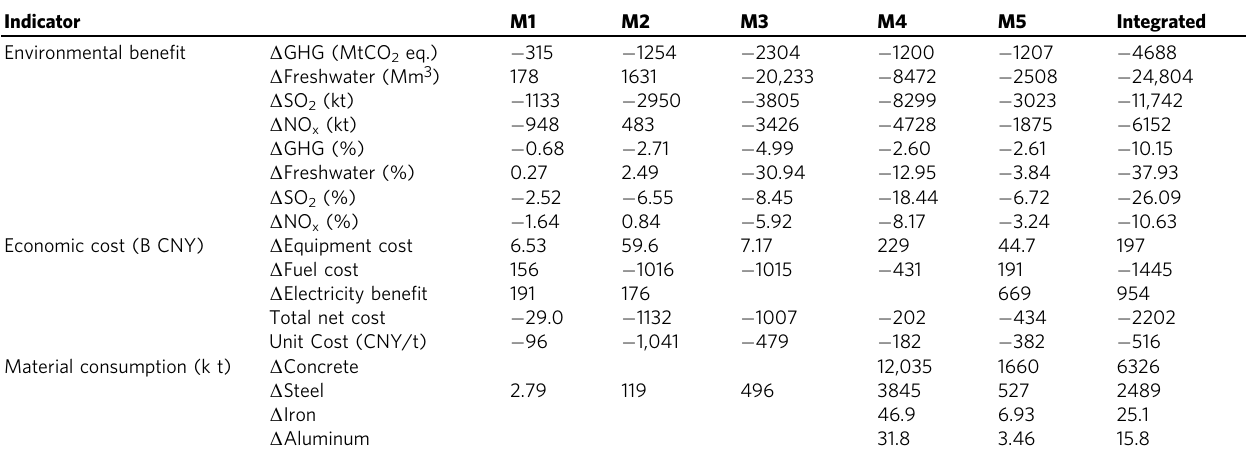
Table 1 Environmental bene fi ts, economic costs, and material consumption in GHG mitigation scenarios. Indicator